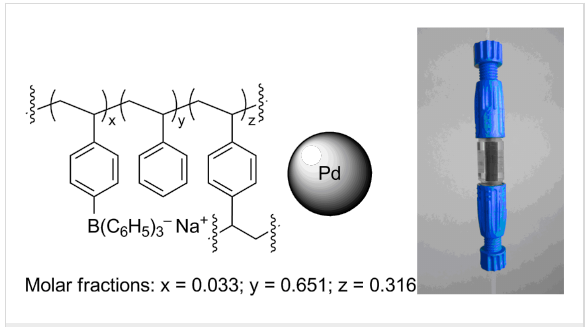
Figure 5: Sketch of composition (left) and optical image of Pd@MonoBor monolithic reactor (right). Adapted with permission from [136], © 2013 Elsevier.